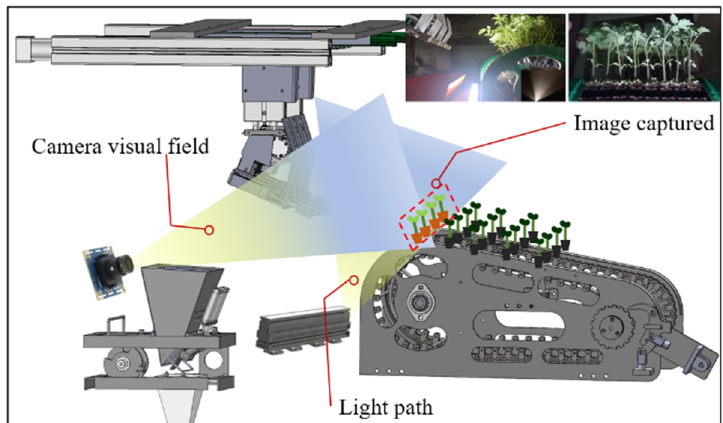
Figure 6. Image acquisition sense.